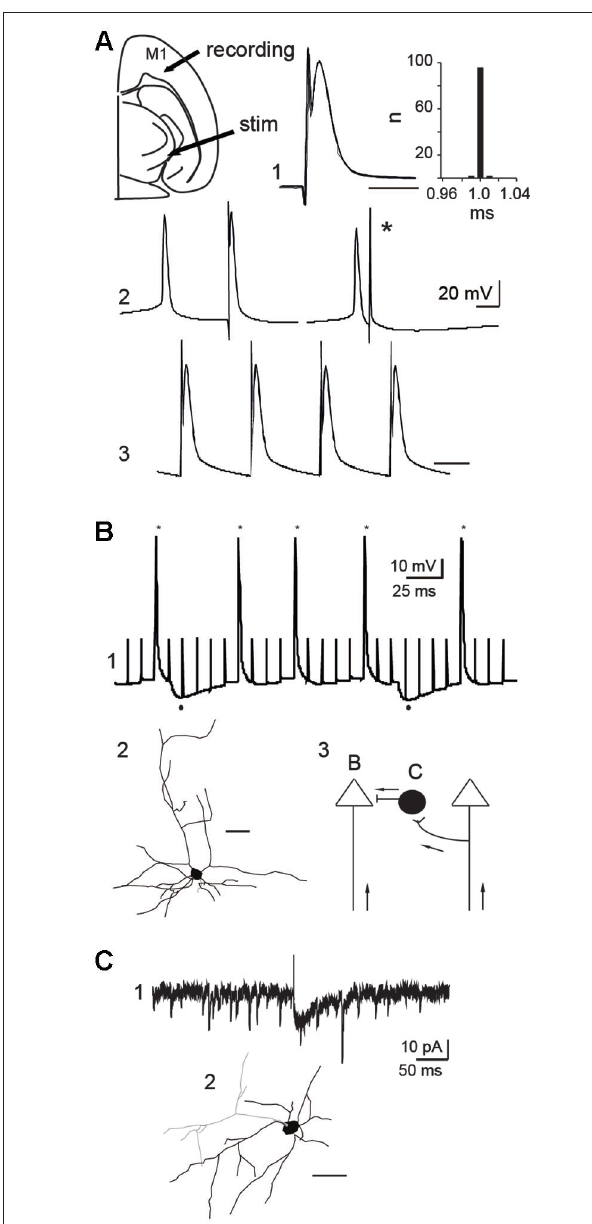
FIGURE 5 | Mechanisms of action of STN-HFS. (A) Antidromic activation of a PINK1 − / − M1 pyramidal neuron in response to rostral STN stimulation in the continuous presence of APV (40 µ M) and CNQX (10 µ M). Schematic illustration of the stimulation and recording sites (top left). Five superimposed traces and latency histogram (A1) , collision test (A2) and 100 Hz stimulation (A3) , respectively showing the fixed latency of the antidromic spike, its collision (*) with a spontaneous spike and its ability to follow a short train of HFS ( V m = − 60 mV, scale bars: 2 ms). (B) Whole cell recording (B1) of a PINK1 − / − pyramidal neuron in control ACSF (current clamp mode, V m = − 50 mV). Stars indicate the antidromic spikes and dots below indicate the two hyperpolarizing responses recorded in response to some of the stimuli (100 Hz). (B2) Biocytin-filled, whole-cell recorded M1 pyramidal neurons of layers V-VI that responded to antidromic stimulation (scale bar 50 µ m). (B3) Schematic illustration of two pyramidal neurons and one interneuron to show recording sites in B and C; Arrows indicate the ( Continued )